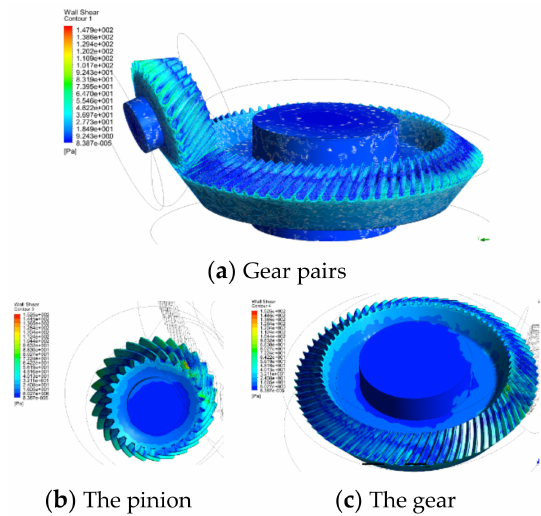
Figure 7. Viscous force distribution of fluid on gears.